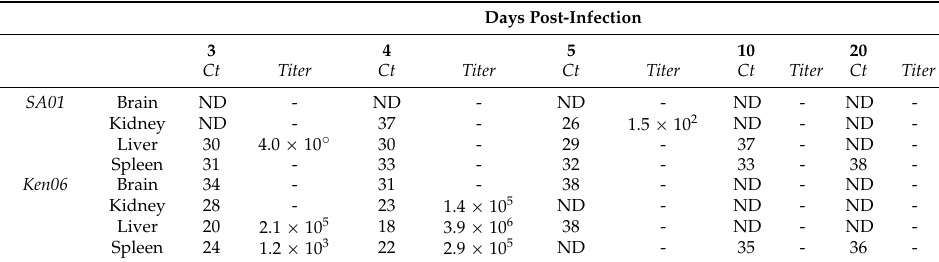
Table 3. Presence of RVFV RNA and virus in tissues at days post-infection.